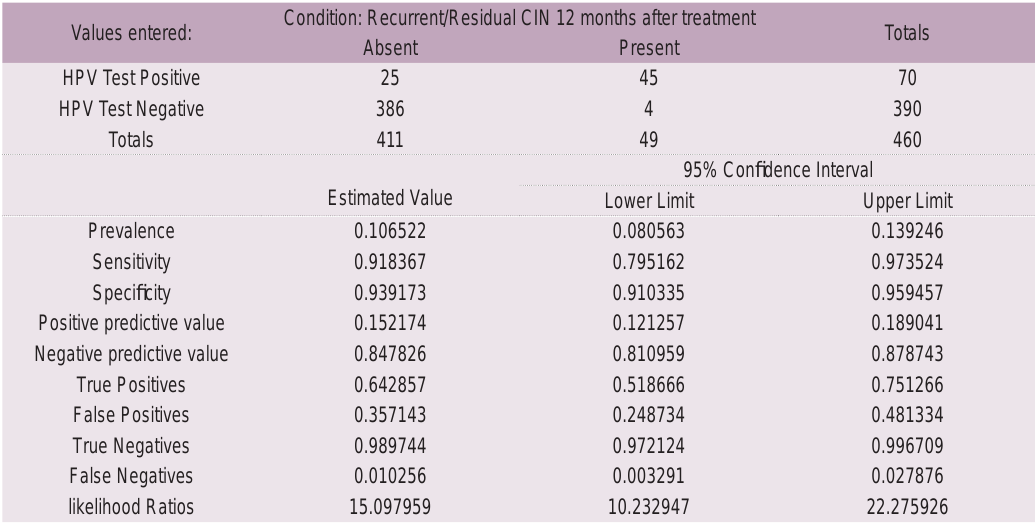
TABLE 2. The role of HPV testing in the follow-up of patients 12 months after treatment for